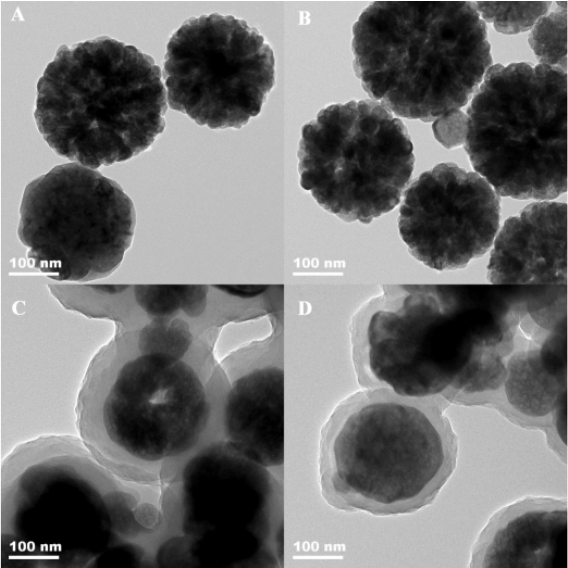
Figure 1. The TEM images for ( A ) Fe 3 O 4 , ( B ) activated Fe 3 O 4 , ( C ) Fe 3 O 4 /P (GMA ‐ MBA) and ( D ) magnetic adsorbent Fe 3 O 4 /P (GMA ‐ MBA) ‐ PO 4 .